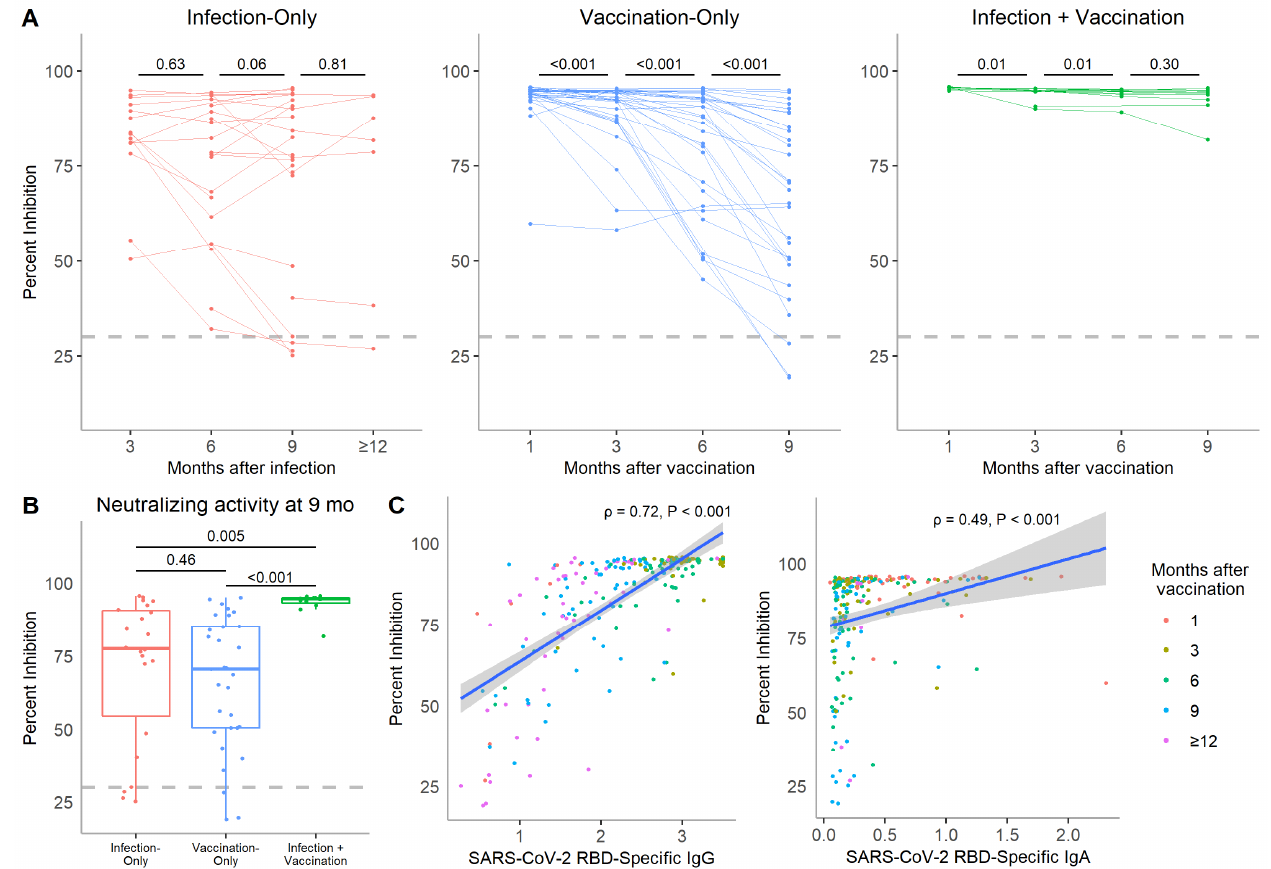
Figure 5. In vitro neutralizing activity in the serum of COVID-19 mRNA vaccinated, SARS-CoV-2 recovered, or both individuals over time. ( A ) SARS-CoV-2 neutralizing activity in paired samples from a subgroup of 22 infection-only participants, 31 vaccination-only participants, and 11 infection + vaccination participants. Neutralizing activity is presented as percent inhibition. The threshold for positive neutralizing activity was set at 30% inhibition based on the manufacturer’s protocol. ( B ) Neutralizing activity at 9 months post-vaccination or infection was compared among the infection- only, vaccination-only, and infection + vaccination groups. ( C ) Spearman correlations between neutralizing activity and RBD-specific IgG and RBD-specific IgA from all 234 serum samples that were analyzed for neutralizing activity are shown. Colors correspond to the time past infection or vaccination. p -values were calculated by Wilcoxon signed-rank tests if between paired time points